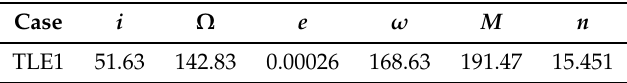
Table 1. Two-line element (TLE) input for simulation.